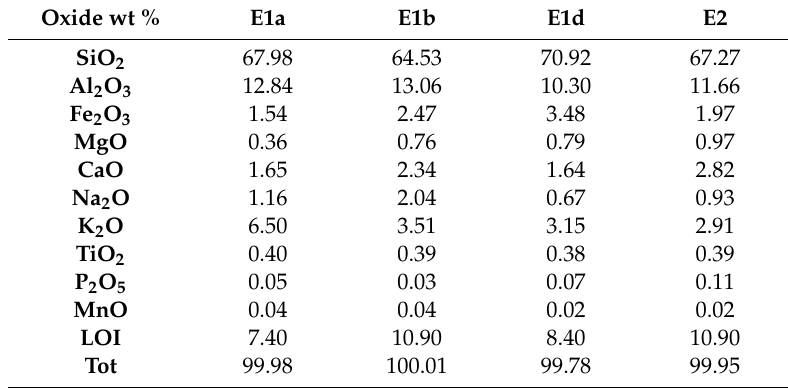
Table 2. Major (wt. %) and minor (ppm) elements concentration of studied samples, obtained by means of ICP